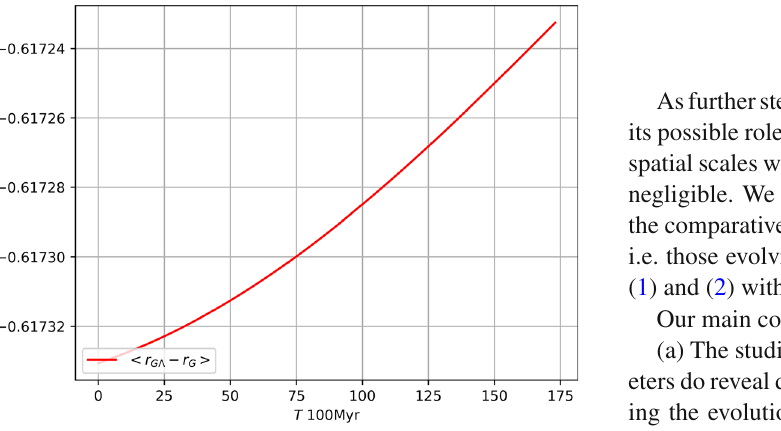
Fig. 3 The same as in Fig. 2 but for supercluster (Virgo) parameters